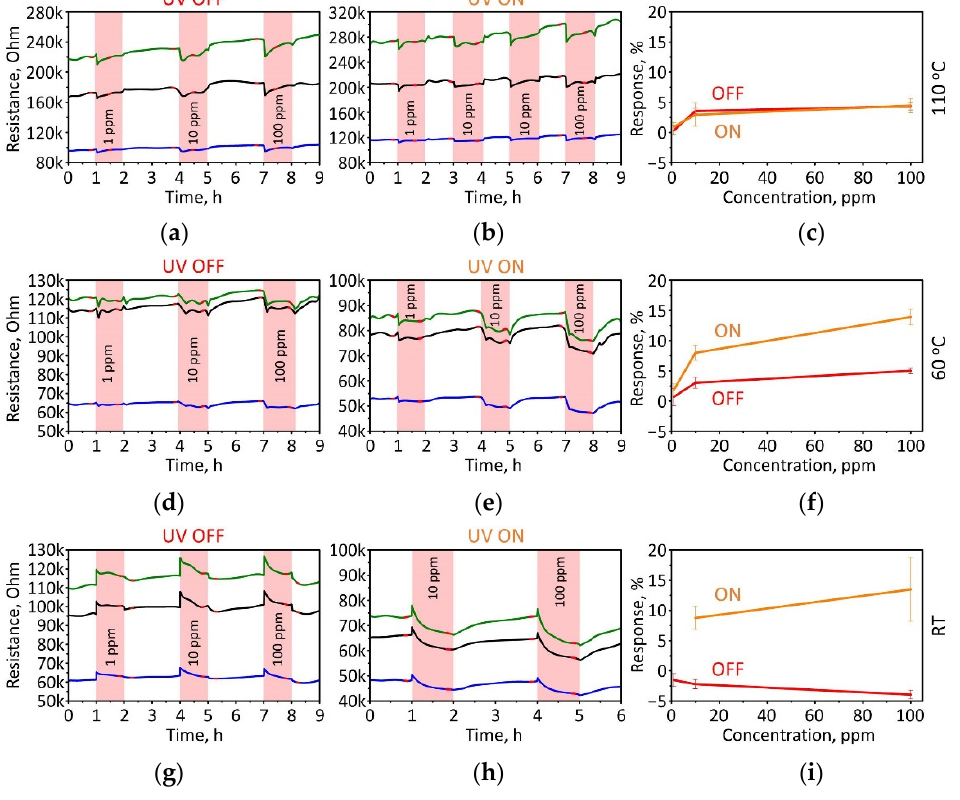
Figure 6. The chemiresistive response of TiS 3 NW mat-based sensor elements upon their exposure to isopropanol vapors. ( a , b ) R(t) transients at 110 °C without ( a ) and with ( b ) UV-LED radiation. ( d , e ) R(t) transients at 60 °C without ( d ) and with ( e ) UV-LED radiation. ( g , h ) R(t) transients at RT without ( g ) and with ( h ) UV-LED radiation. The red data points were used for response calculations. ( c , f , i ) Response-to-concentration curves at various operation regimes: 110 °C ( c ), 60 °C ( f ), RT ( i ). The error bars represent the scattering observed over the sensor array. The green, black and blue curves indicate resistances of three different sensor elements.